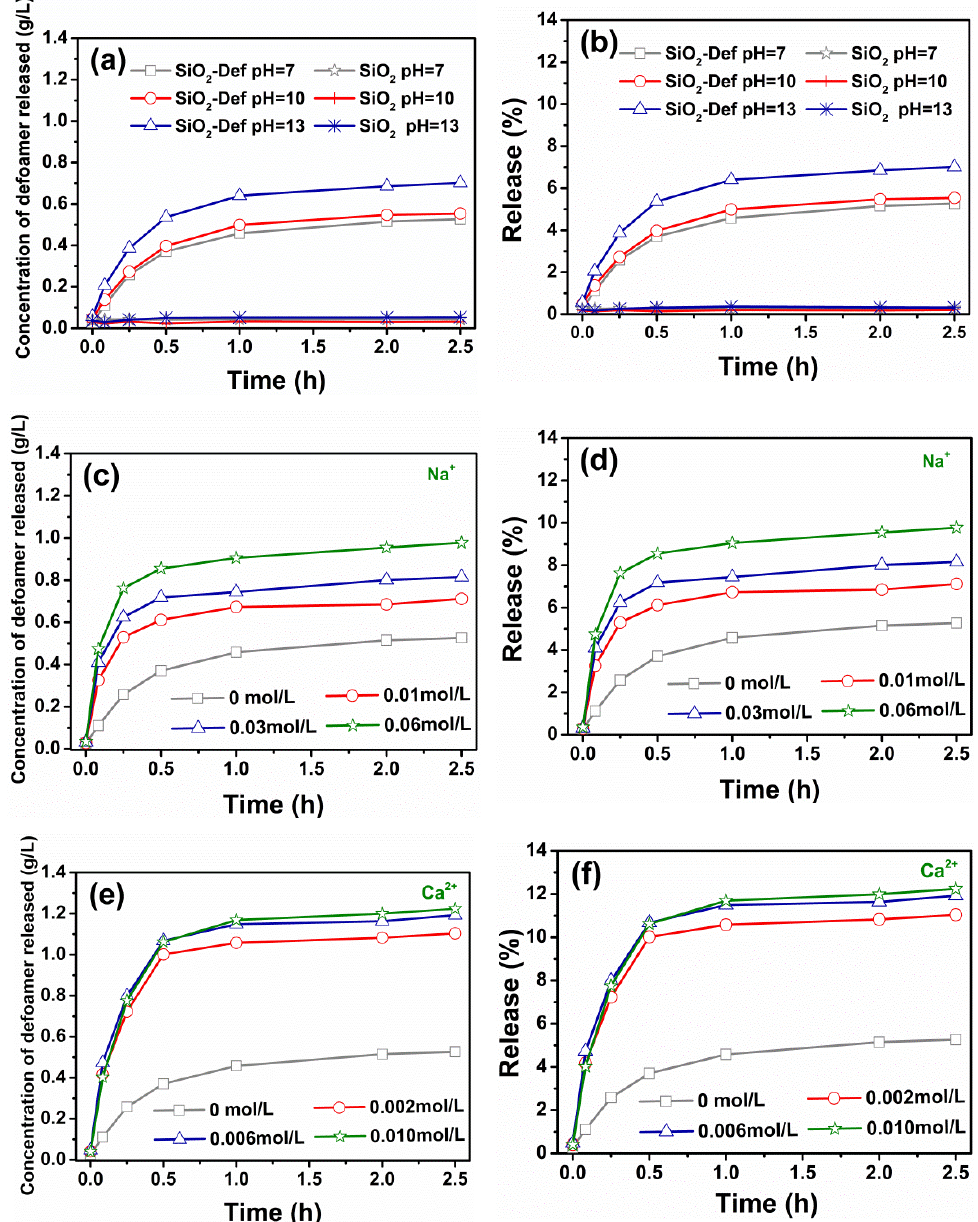
Figure 8. Release profile of SiO 2 -Def under different conditions: ( a , b ) different pH; ( c , d ) different concentrations of Na + ; ( e , f ) different concentrations of Ca 2+ .